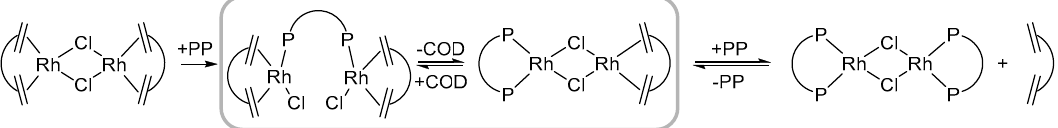
Figure 7. 31 P NMR spectrum of the solution obtained from reaction of [Rh(COD)( µ 2 -Cl)] 2 and DPEPhos, in a 1:2 mixture, 10 min after mixing of the reagents: X-ray structures of the species detected in solution [(COD)Rh( µ 2 -Cl) 2 Rh(DPEPhos)], black, [Rh(DPEPhos)( µ 2 -Cl)] 2 , red, and [Rh 2 ( µ 2 -DPEPhos)(COD) 2 (Cl) 2 ], yellow.